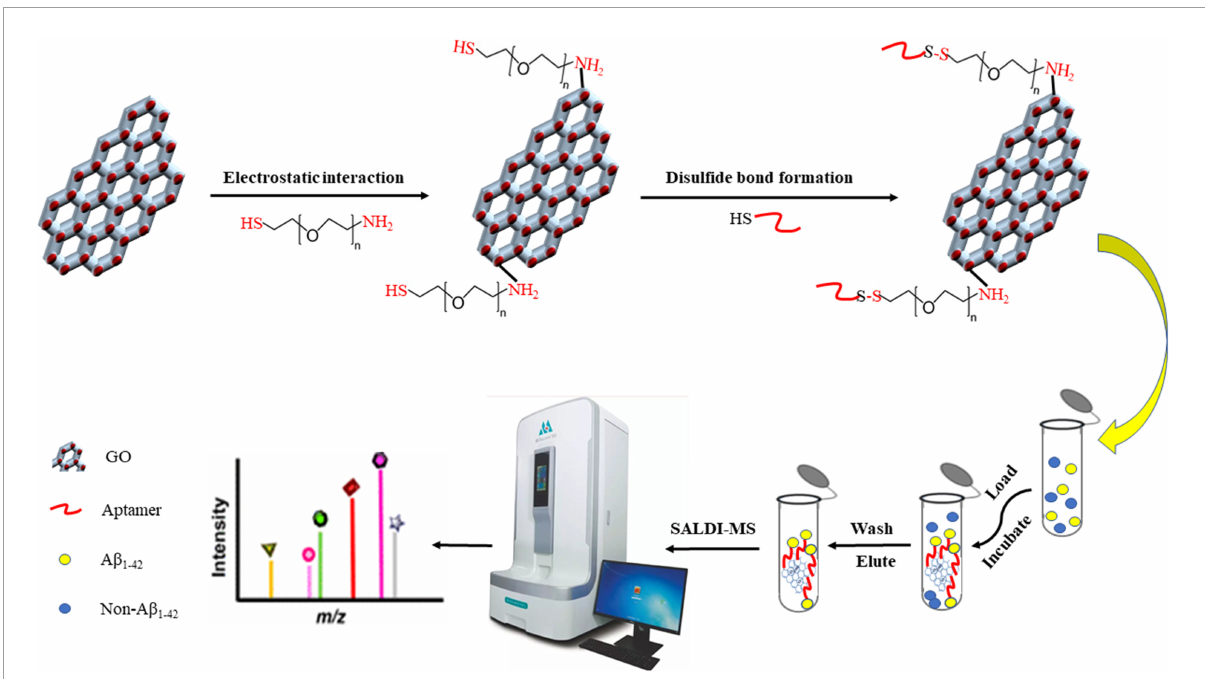
FIGURE1 Procedure of the aptamer-modified GO nanoparticles fabrication and application for detecting A β 1 − 42 coupled with SALDI